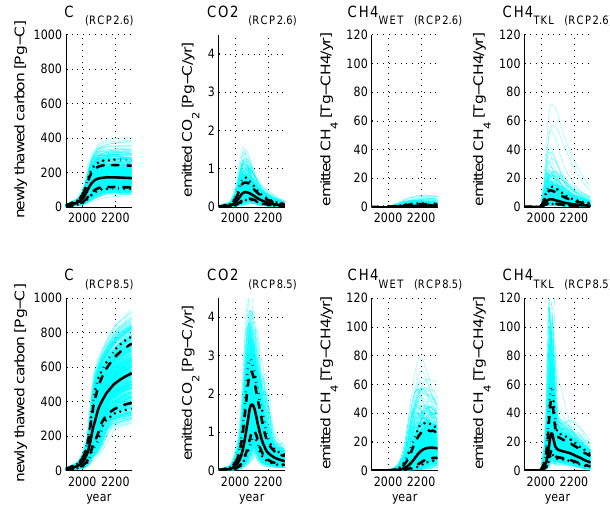
Figure 3. Simulated increase in newly thawed permafrost carbon C and resulting rates of annual CO 2 and CH 4 release under moderate (upper panels) and extensive (lower panels) global warming for the years 1900 to 2300. CH 4 release is shown separately for fluxes from wetlands (WET) and newly formed thermokarst lakes (TKLs). Blue lines show ensemble simulation results based on 500 model runs which account for parameter uncertainty. Black lines show statisti- cal quantiles (solid line: median; dashed lines: 68% range; dotted lines: 80% range). Shown are contributions aggregated over all in- dividual pools, summed over all latitudes and depths layers.